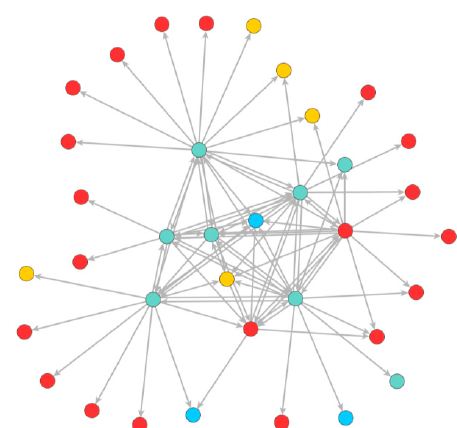
Figure 1. Power in Case 1.